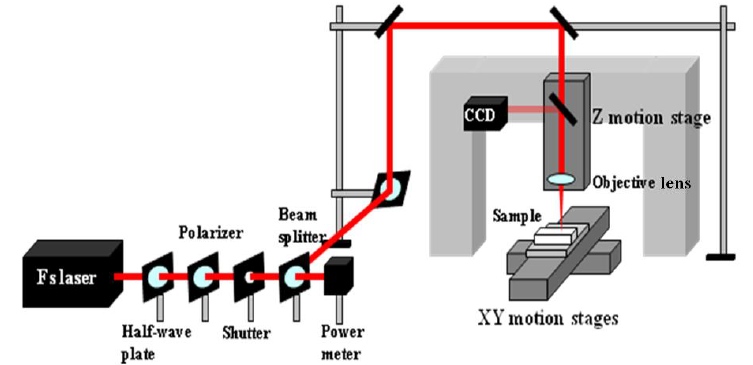
Figure 3. Schematic illustration of an ultrafast laser microfabrication station.